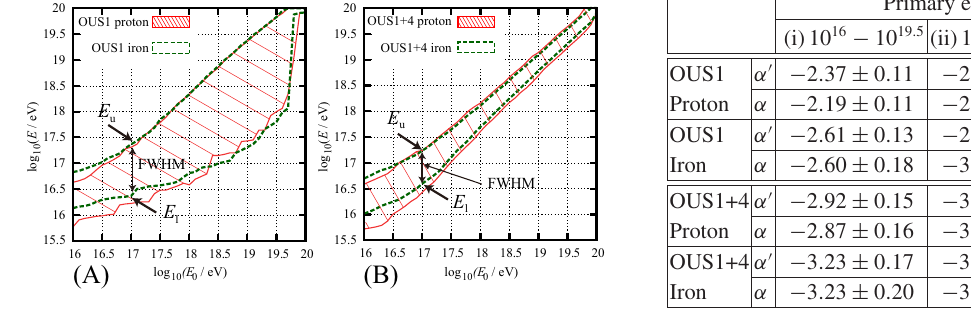
Figure 4. The energy resolution bands in the OUS1 (A) and the OUS1+4 (B). The shaded bands indicate the result of assumption of proton primaries. The dashed line bands indicate the result of assumption of iron primaries.